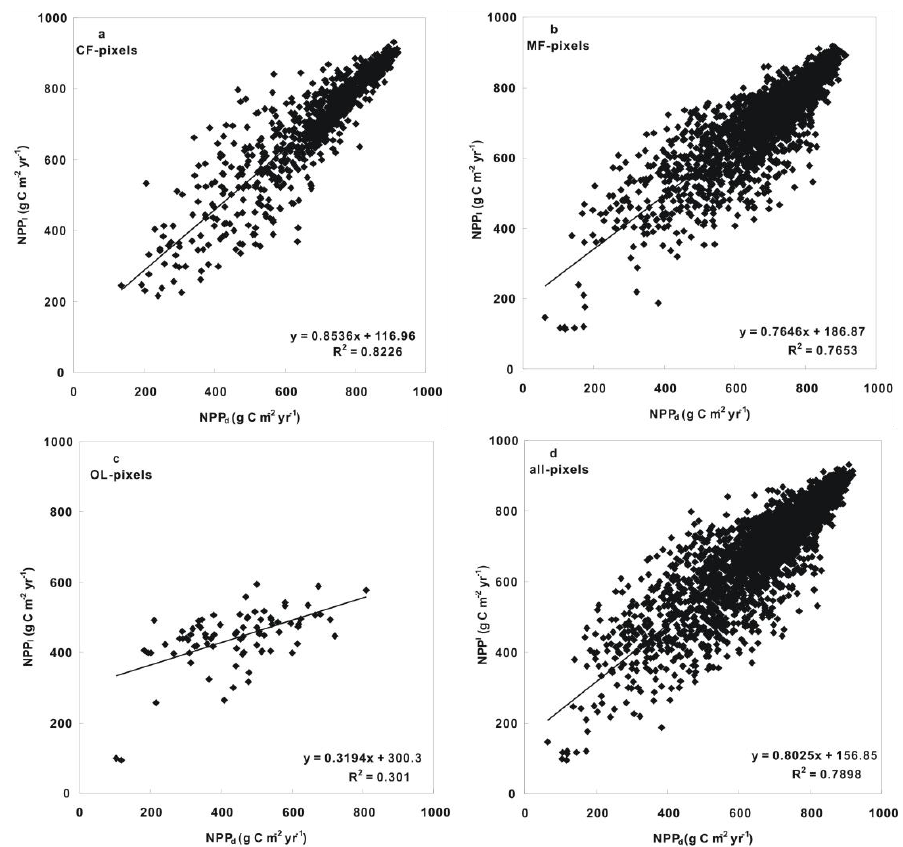
Fig. 12. Regression between distributed (NPP d ) and lumped (NPP l ) annual values after elevation (SSI ELE ) correction: (a) pixels dominated by the coniferous forest (CF-pixels); (b) pixels dominated by the mixed forest (MF-pixels); (c) pixels dominated by open land (OL-pixels); Figure 12. Regression between distributed ( NPP d ) and lumped ( NPP l ) annual values 3 and (d) all pixels for all land cover types (all-pixels). after elevation ( SSI ELE ) correction: (a) pixels dominated by the coniferous forest 4 (CF-pixels); (b) pixels dominated by the mixed forest (MF-pixels); (c) pixels 5 Table 4. Statistics of the distributed and lumped NPP. Shown are averaged values of coniferous and mixed forest excluding open land in dominated by open land (OL-pixels); and (d) all pixels for all land cover types 6 (all-pixels). 7 Distributed NPP Lumped NPP before correction Lumped NPP after